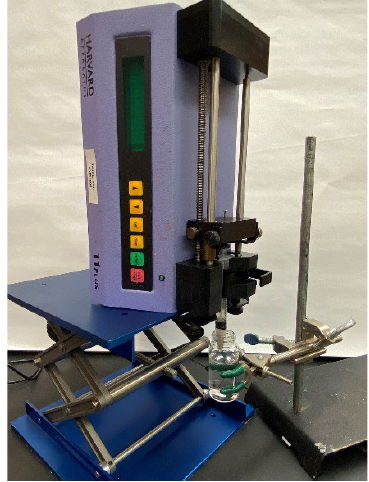
Figure 1. The immersed microfluidic spinning setup that includes a pump displacing the plunger of a syringe filled with a sodium alginate solution. The needle of the syringe is immersed in a bath of calcium chloride.